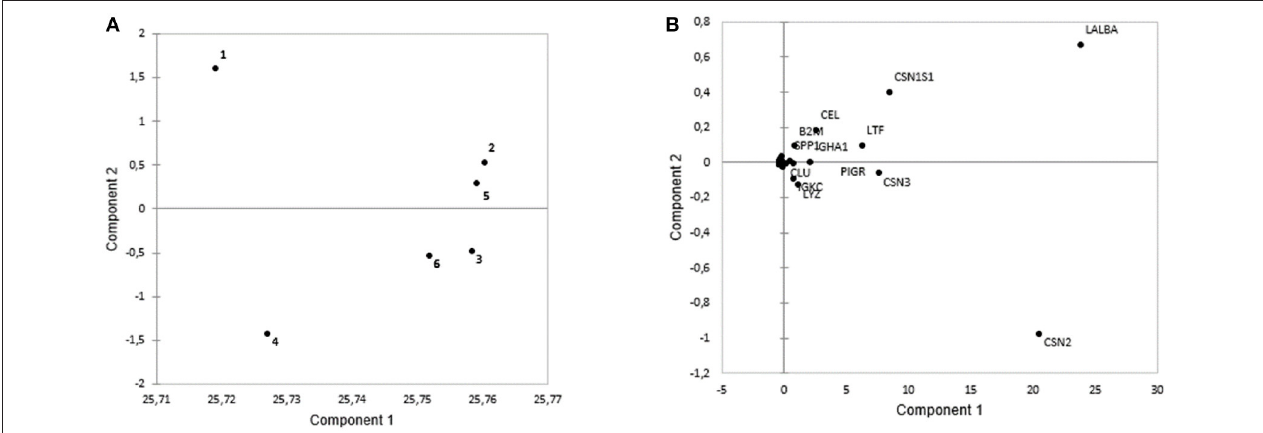
FIGURE 3 | The PCA plots based on protein intensity of: (A) Different lactation periods during the 6 months of lactation. The first pool includes the 1st, 2nd, and 5th month of lactation, while second pool includes the 3rd, 6th, and 4th month of lactation. (B) Loading plots based on intensity of the proteins based on the different lactation periods. The first pool was abundant in LALBA, CSN1S1, CEL, LTF, B2M, SPP1, and IGHA1. Meanwhile, the second pool was abundant with CLU, PIGR, IGKC, LYZ, and CSN.